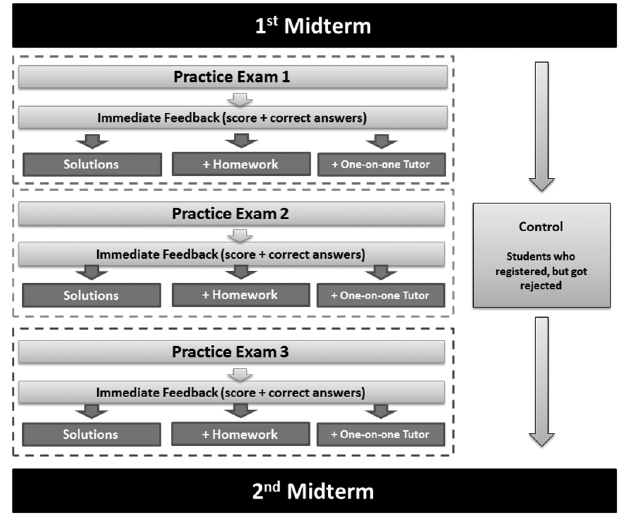
FIG. 2. (a) Number of participants for each group. Participants who missed the previous session were not allowed to participate in the rest of the experiment. (b) Initial score on the first midterm (incomplete participants